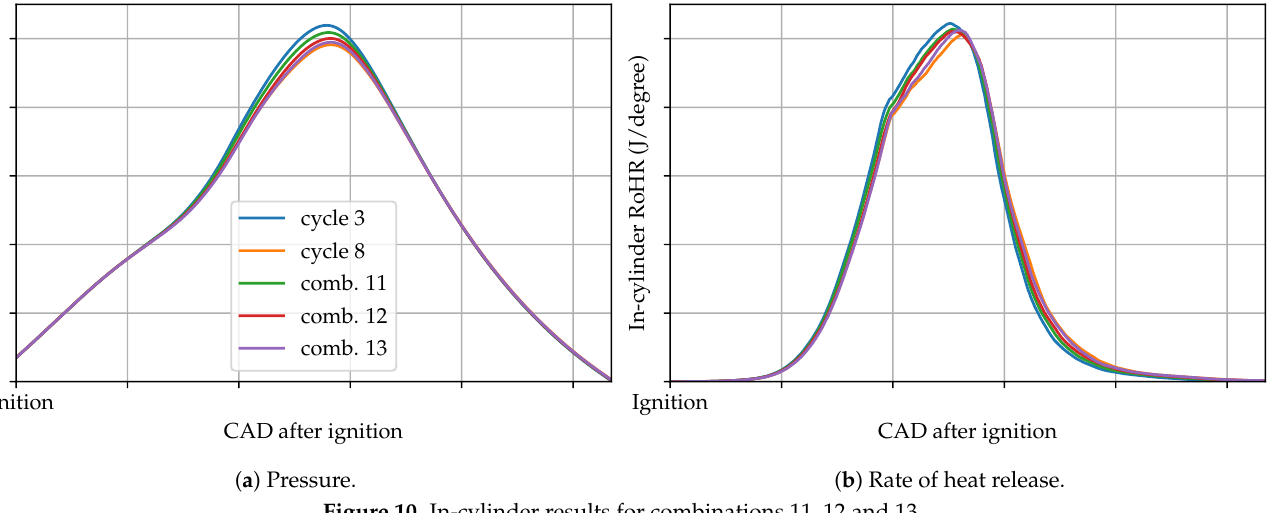
Figure 10. In-cylinder results for combinations 11, 12 and 13. Combinations 14, 15 and 16 are equal to combinations 11, 12 and 13 with the exception of the time when the snapshot is taken being shifted to 0.5 CAD before ignition. This leads to a lower peak pressure, shown in Figure 11, which means that these combinations are closer to the 0% peak pressure cycles than the combinations with an earlier snapshot